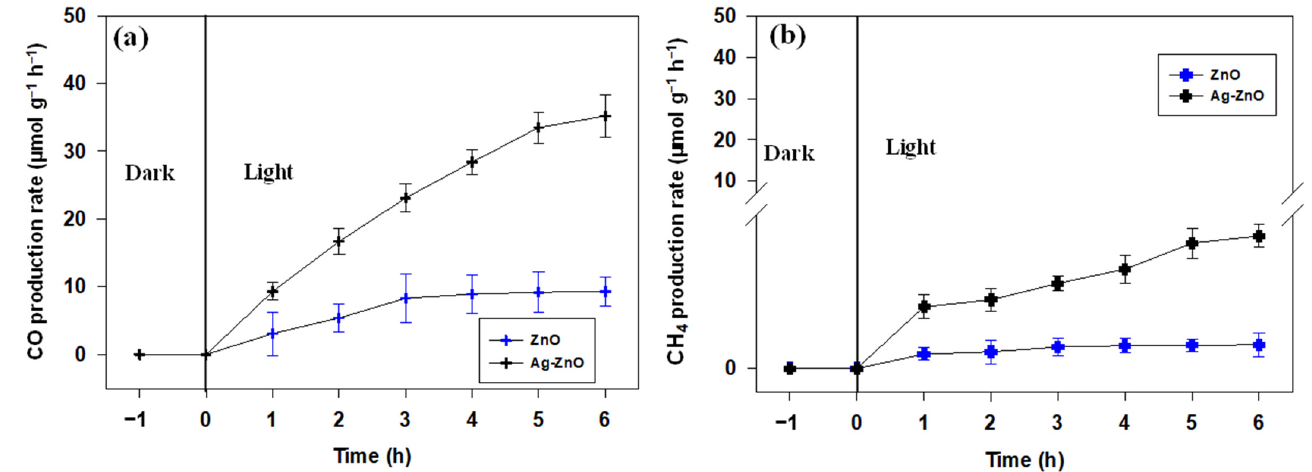
Figure 6. CO 2 conversion into ( a ) and CH4 ( b ) by ZnO and Ag-ZnO. Under the dark condition, there are no photocatalytic activities for CO 2 conversion was observed for both ZnO and Ag-ZnO.